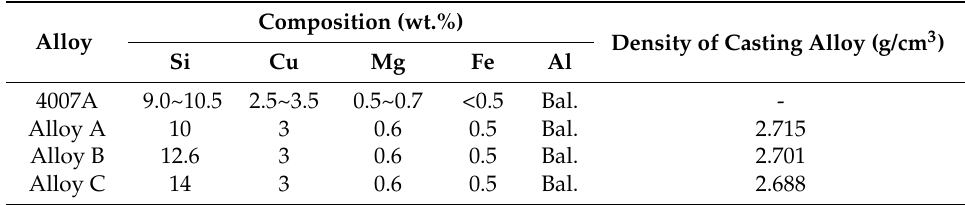
Table 1. Nominal chemical composition of Al-XSi-3Cu-0.6Mg-0.5Fe [X = (a): 10 (Alloy A), (b): 12.6 (Alloy B), (c): 14 (Alloy C)] cast